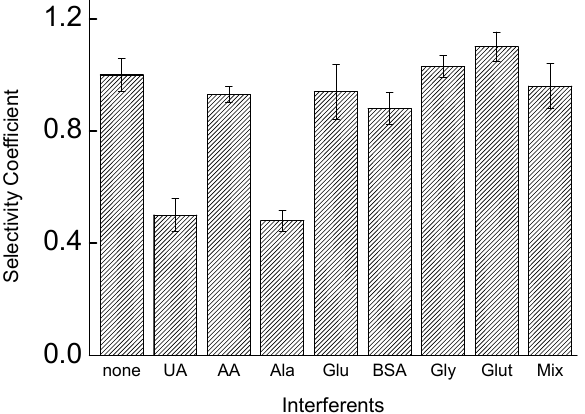
Figure 5. Selectivity coefficient for graphite electrode/poly(4-ATP)/EBV1 in the detection of complementary target in absence or presence of the interfering compounds: uric acid (UA) 1 mg·dL − 1 ; ascorbic acid (AA) 3.6 mg·dL − 1 ; glycine (Gly) 1 mmol·L − 1 ; alanine (Ala) 1 mmol·L − 1 ; glucose (Glu) 1 mmol·L − 1 ; bovine serum albumin (BSA) 5 g·dL − 1 ; glutamate (Glut) 1 mmol·L − 1 and mixture. Electrolyte: phosphate buffer (0.10 mol·L − 1 ), pH 7.4. Modulation amplitude: 25 mV. Pulse interval: 0.2 s; Scan rate 20 mV·s − 1 . Ethidium bromide (1 × 10 − 6 mol·L − 1 ) was used as indicator of the